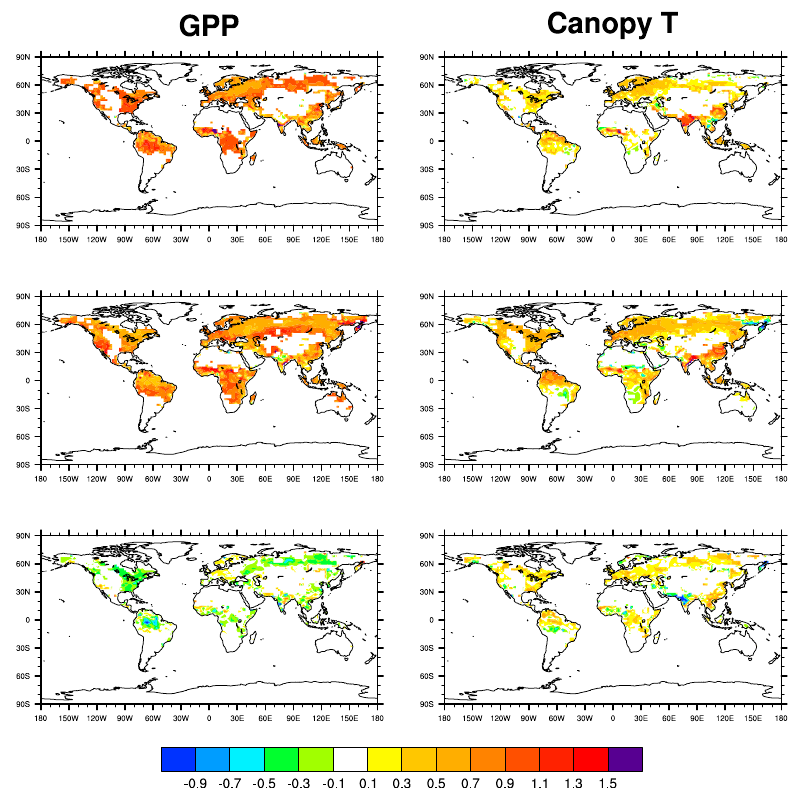
Fig. 3. Standardized regression coefficients between isoprene emission and the key drivers GPP (left column) and canopy temperature (right column). Results shown are averages for June-July-August in SimCONT (top row), SimH2O (middle row), and the difference [SimH2O – SimCONT] (bottom row).